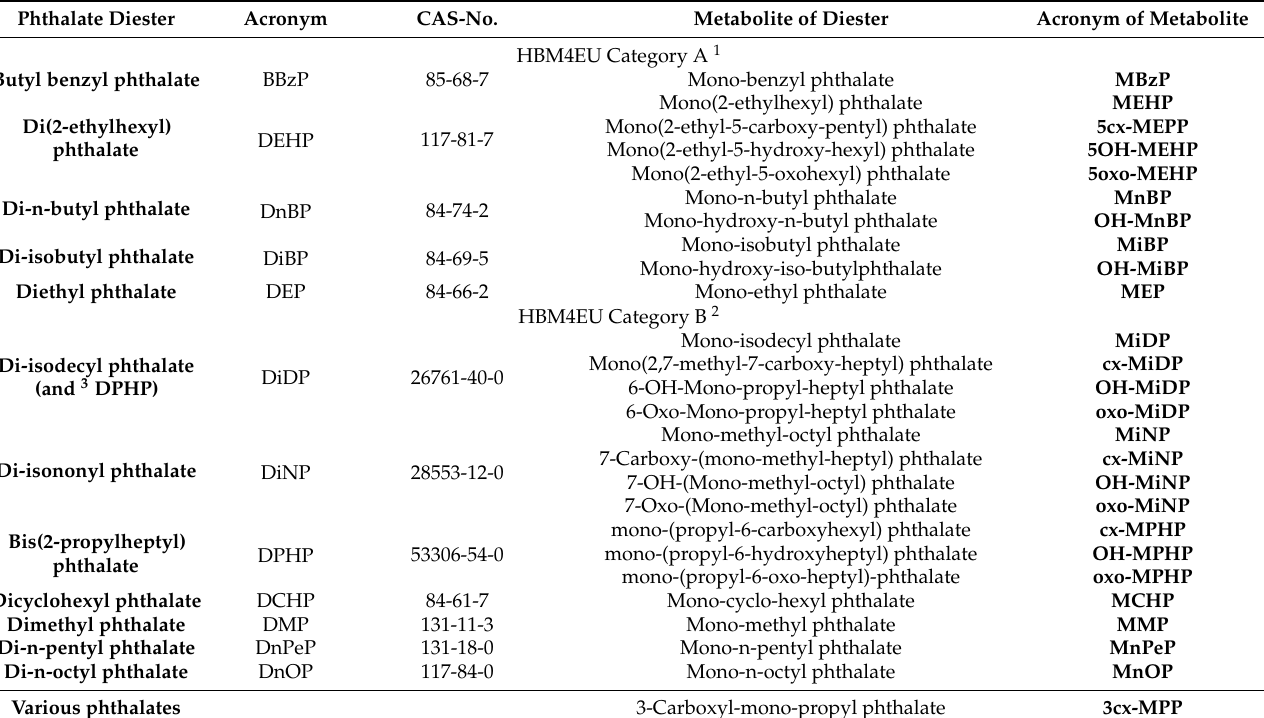
Table 2. Phthalate compounds and their measured